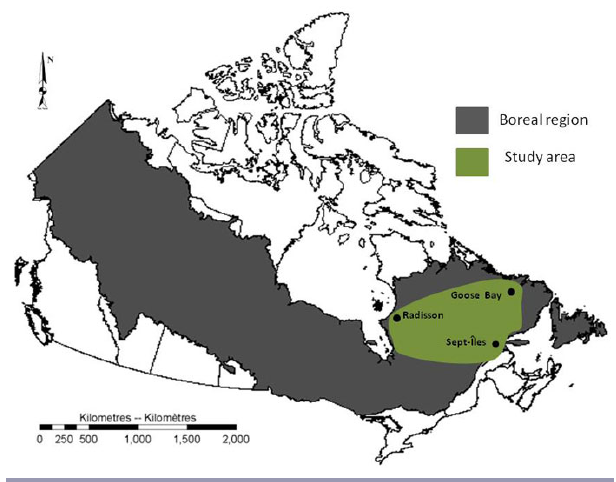
Fig. 1 . Location of the study area in the eastern Canadian Boreal Shield, a forest region dominated by black spruce ( Picea mariana